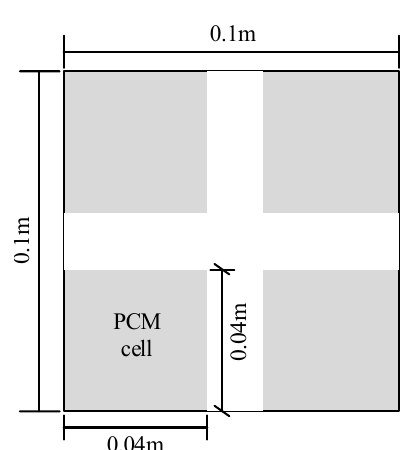
Figure 1. PCM mat with PCM